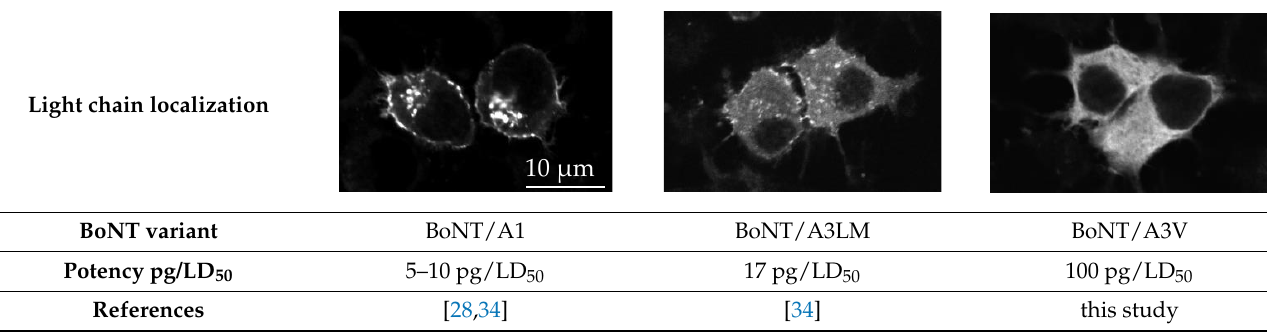
Table 2. Potency of BoNT/A variants in a mouse model of botulism 1 .